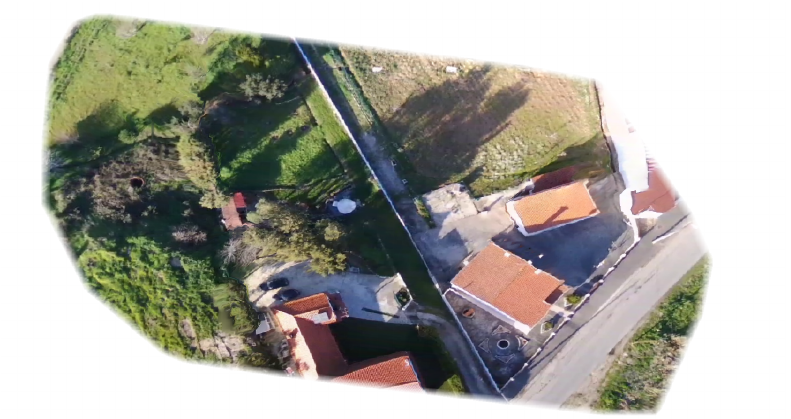
Figure 25. Orthomap generated from RGB imagery. Two points of the point cloud are approximately distanced by 0.09